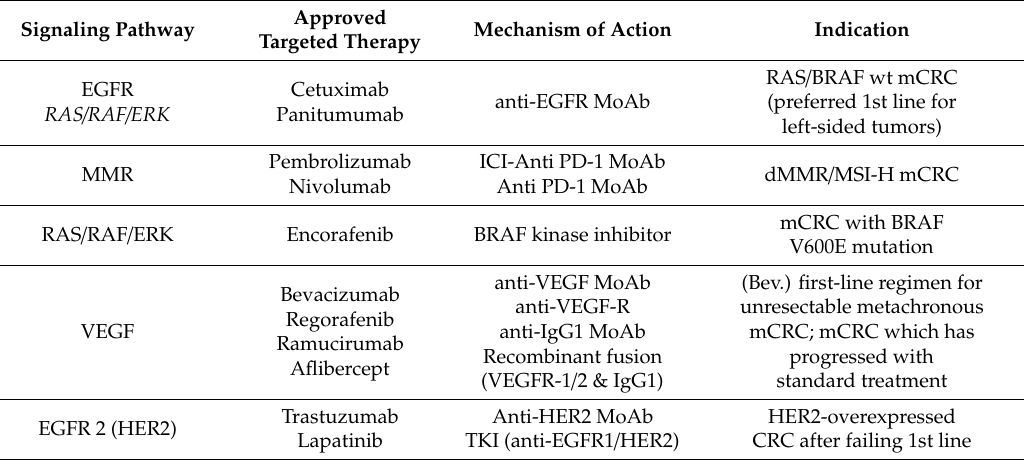
Table 1. Common approved targeted therapy for colorectal